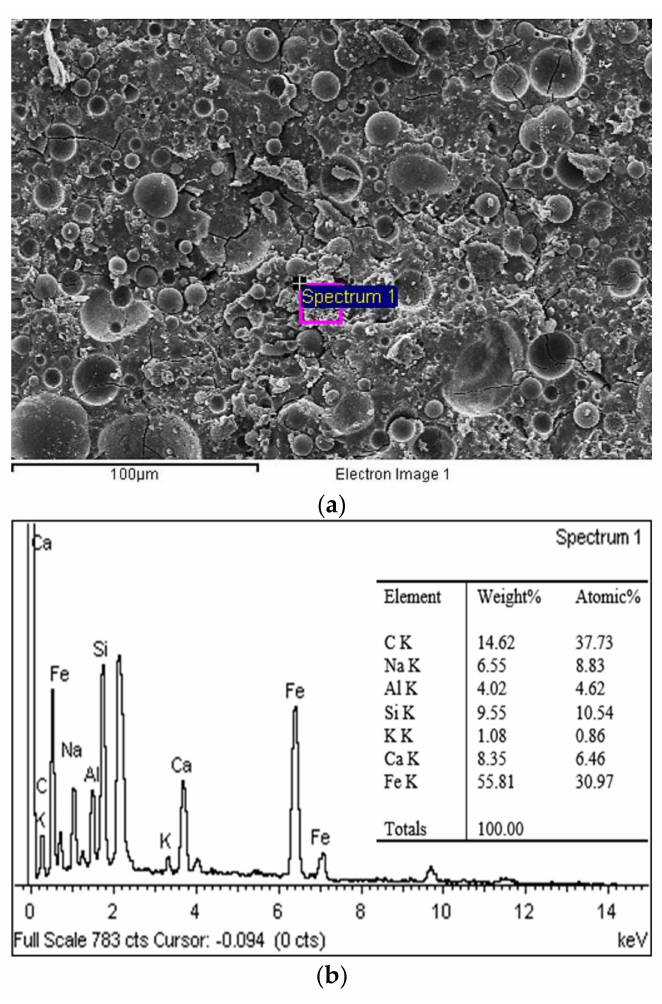
Figure 10. ( a ) SEM and ( b ) EDX results of W20GP at 28-day curing time. Nevertheless, the reduction in compressive strength must be explained. The main component of Fe in WIP reacted with the high alkaline solution. The product from this reaction was Na 2 [Fe(OH) 4 ] under heat curing. The occurrence of Na 2 [Fe(OH) 4 ] increased in the volume of iron compounds, causing stresses in the geopolymer matrix [37–39]. Zeolite could form when an SS/SH of 1.0 was used in the mixture [40]. After that, the microcracks occurred in the structure, resulting in the reduction of compressive strength and flexural strength in the passing time. The presence of iron compound in the microstructure. These crystalline expansions weakened the completion of the geopolymer structure, according to XRD analysis. The crystalline phases of kyanite, portlandite, and C–S–H gel of tobermorite, which were the main products of geopolymerization and pozzolanic reaction, were reduced when the high amount of WIP was added. The presence of Fe and Na 2 [Fe(OH) 4 ] chemically reduced the strength. These products hindered the dissolution of the Al 4+ and Si 3+ ions at the FA particle’s surface, which could lead to an insufficient geopolymeric reaction. However, only in WGP samples, the higher amount of WIP contributed more compressive strength because of the increased density in the